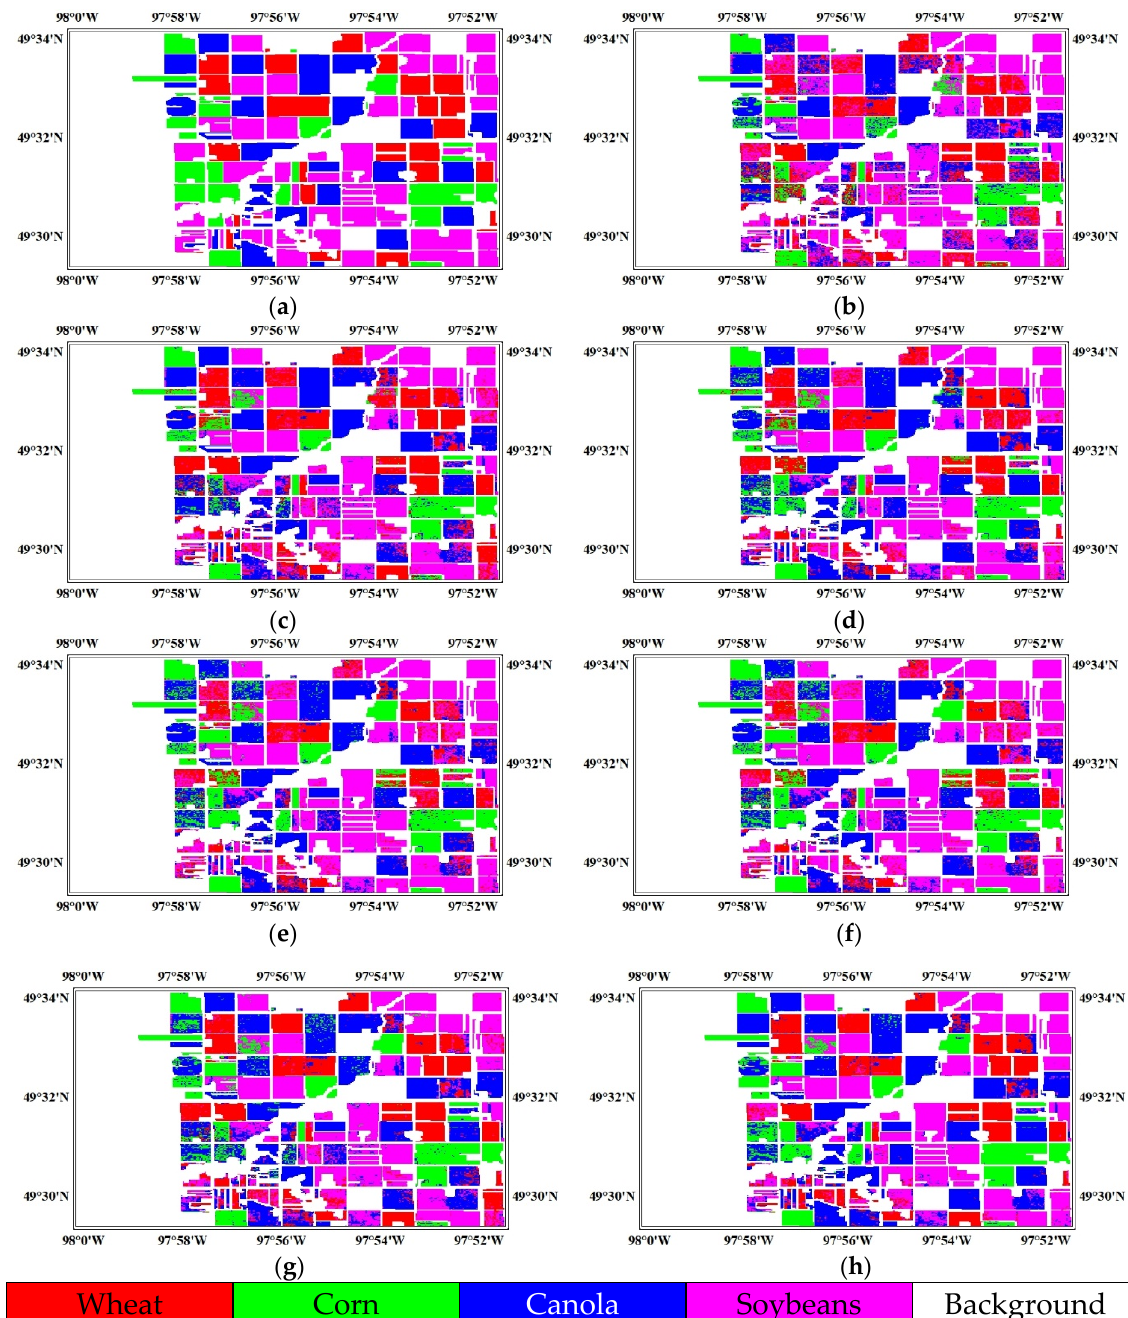
Figure 2. Ground truth map and classification maps in Winnipeg (SD: A -> TD: B), generated by di ff erent methods: ( a ) Ground truth; ( b ) DAC; ( c ) TCA + DAC; ( d ) SSTCA + DAC; ( e ) MIDA + DAC; ( f ) SMIDA + DAC; ( g ) SMbDA + DAC; ( h ) WSMbDA +